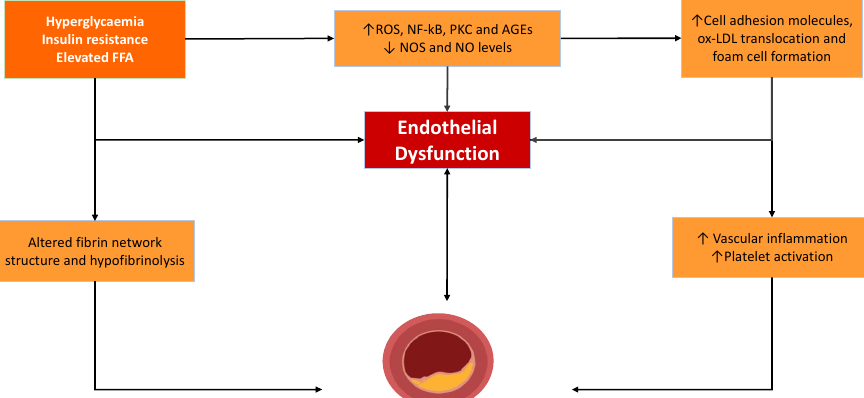
Figure 1. Factors contributing to endothelial dysunfction, elevated vascular inflammation, platelet activation driving the development of atheroma and intravascular thrombus. Abbreviations; FFA: Free Fatty Acids, ROS: Reactive Oxygen Species, NF-kB: nuclear factor kappa-light-chain-enhacer of activated B cells, PKC: protein kinase C, AGEs: Advanced Glycation End Products, ox-LDL: oxidised-low density lipoprotein.